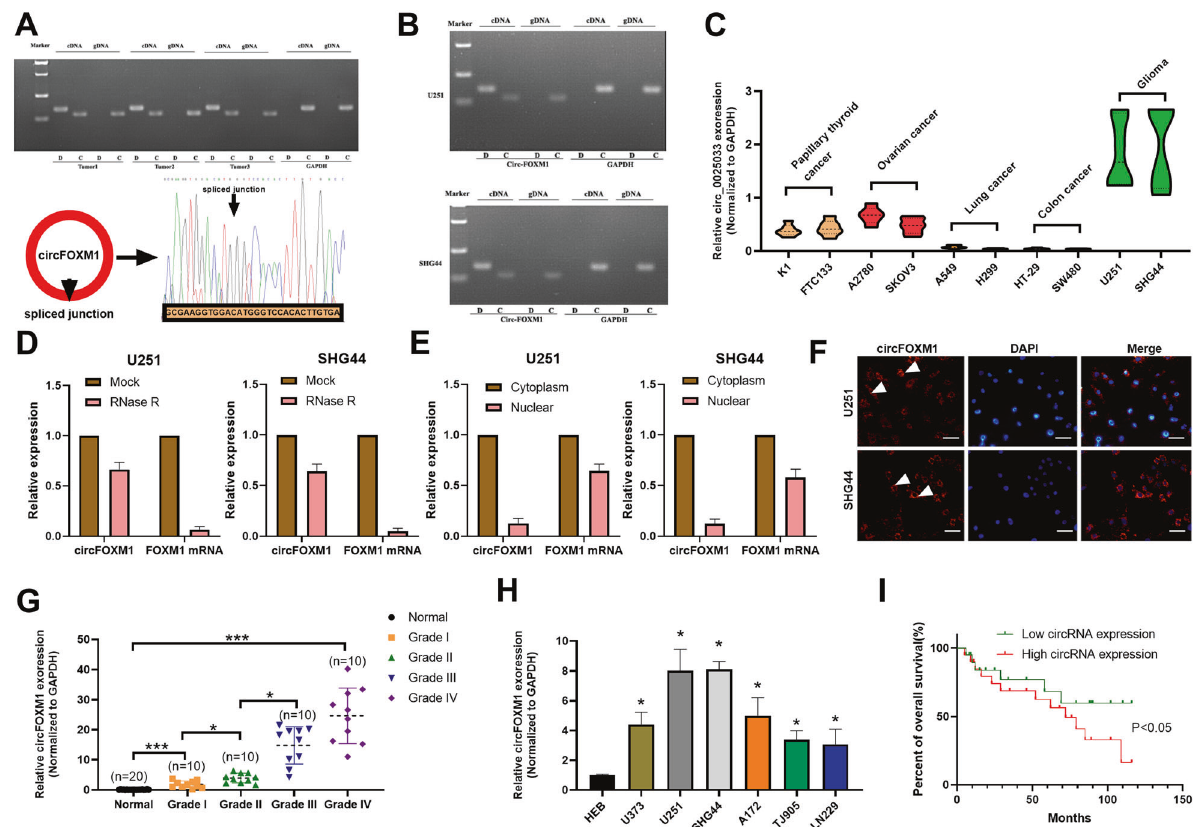
Fig. 1 Identi fi cation of circFOXM1 in glioma cells. A Two pairs of primers were designed to detect the presence of circFOXM1 in 3 glioma tissues (D represents the reverse primer and C represents the forward primer). B PCR assay to detect the expression of circFOXM1 in two glioma-cell lines. C qRT-PCR to detect the expression of circFOXM1 in different cancer-cell lines. D Expression of circFOXM1 in glioma cells via qRT-PCR when RNase R was used. E Expression of circFOXM1 in the cytoplasm and nucleus of glioma cells via qRT-PCR. F circFOXM1 localization in glioma cells by immuno fl uorescence. G Relative expression of circFOXM1 in glioma tissues of different grades. H Relative expression of circFOXM1 in different glioma cell lines. I Survival curve of glioma patients with high expression of circFOXM1 and low expression of circFOXM1 (* P < 0.05, *** P <